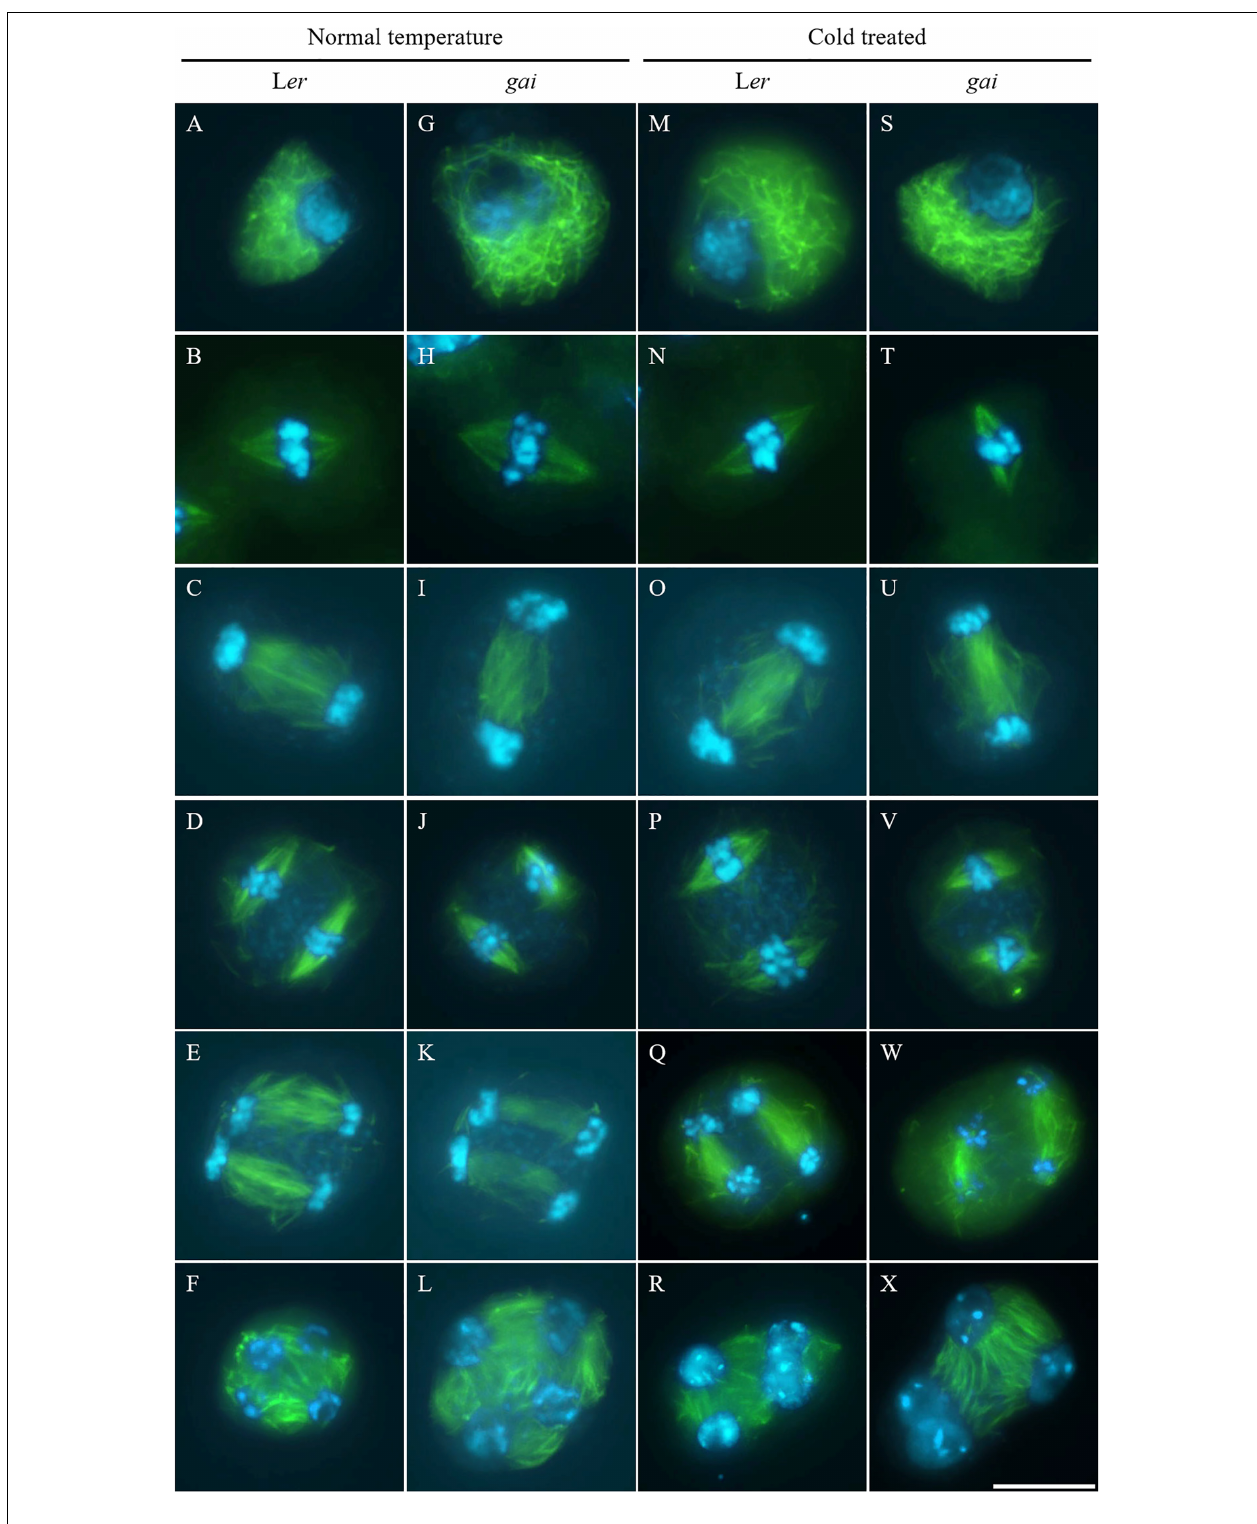
FIGURE 3 | Cold interferes with radial microtubule array (RMA) formation in the gai mutant. (A–L) Meiotic microtubule structures at prophase (A,G) , metaphase I (B,H) , interkinesis (C,I) , metaphase II (D,J) , anaphase II (E,K) and telophase II stage (F,L) meiocytes in wild type L er (A–F) and the gai mutant (G–L) plants under control conditions. (M–X) Meiotic microtubule structures at prophase (M,S) , metaphase I (N,T) , interkinesis (O,U) , metaphase II (P,V) , anaphase II (Q,W) and telophase II stage (R,X) meiocytes in cold-stressed wild type L er (M–R) and the gai mutant (S–X) plants. Green: α -tubulin, cyan: DAPI. Scale bars = 10 µ m.